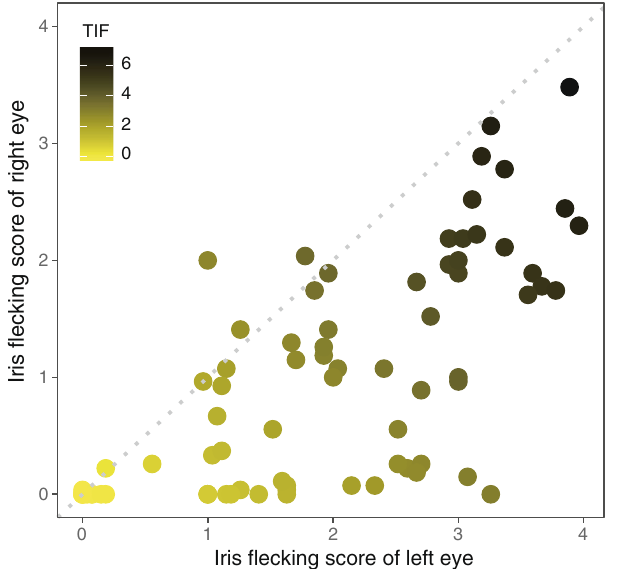
Figure 2. A scatter plot showing the relationship between the left and right eye in the amount of iris flecking. Each dot represents each individual and the color was graded according to total iris flecking (TIF). The dotted line indicates the location when the left and right eyes have the same amount of iris flecking.